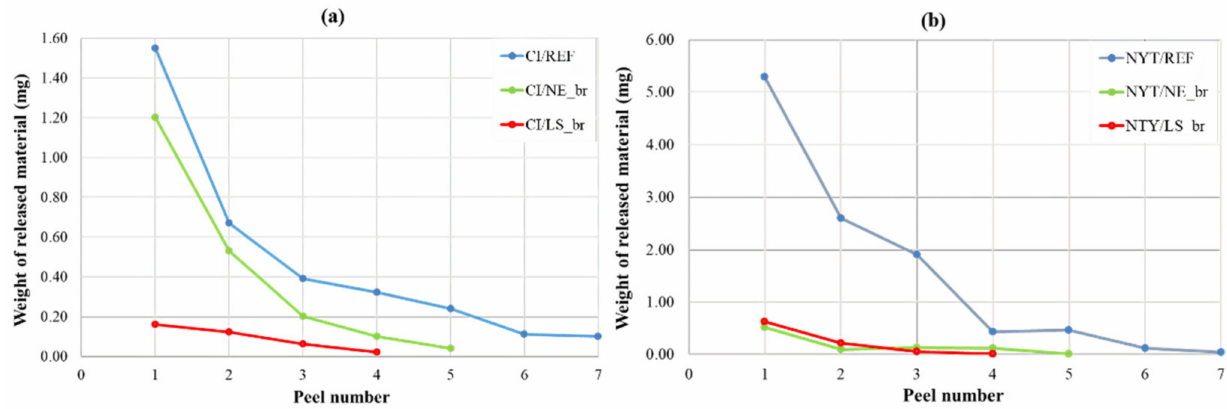
Figure 10. Scotch tape test results on CI ( a ) and NYT ( b ) samples before and after brushing treatment with NE and